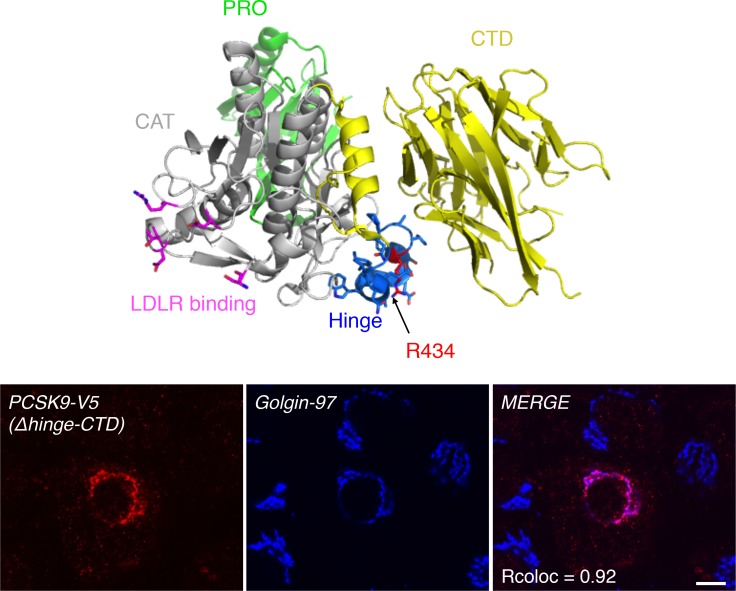
Deletion of PCSK9 hinge region does not affect CTD localization at the TGN.PCSK9 molecular structure was extracted from PDB 2P4E using MacPymol software. Prodomain (PRO), catalytic domain (CAT) and its LDLR-interacting residues (in pink), hinge region in blue and position R434 in red (site of LOF R434W) and C-terminal domain (CTD) are indicated. HepG2 cells were transfected with V5-tagged ΔHinge-CTD (Δaa 422-439-CTD), immunolabeled with the anti-V5 and anti-Golgin-97 antibodies and their localization was analyzed by confocal microscopy (lower panels). Colocalization was quantified using Pearson’s correlation coefficient (Rcoloc) (minimum of 10 cells were analyzed). Data are representative of at least three independent experiments. Scale bar, 10 μm.